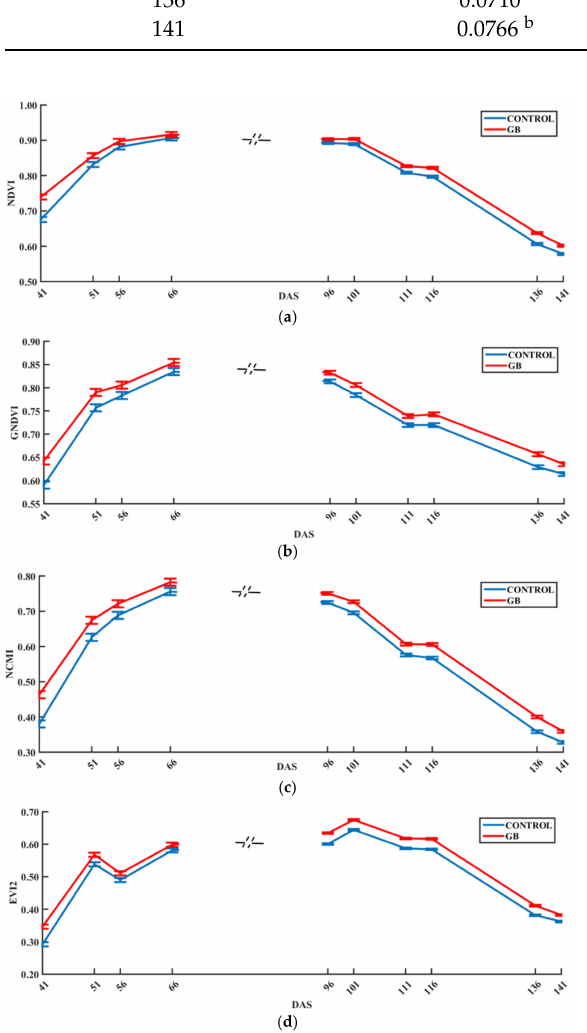
Figure A1. Average values for NDVI ( a ), GNDVI ( b ), NCMI ( c ) and EVI2 ( d ) for each available date before ( left ) and after ( right ) the NDVI peak using Sentinel-2 data once the effect of the crop predominates over the soil (the vertical bars indicate the LSD interval ( p < 0.05) for the separation of